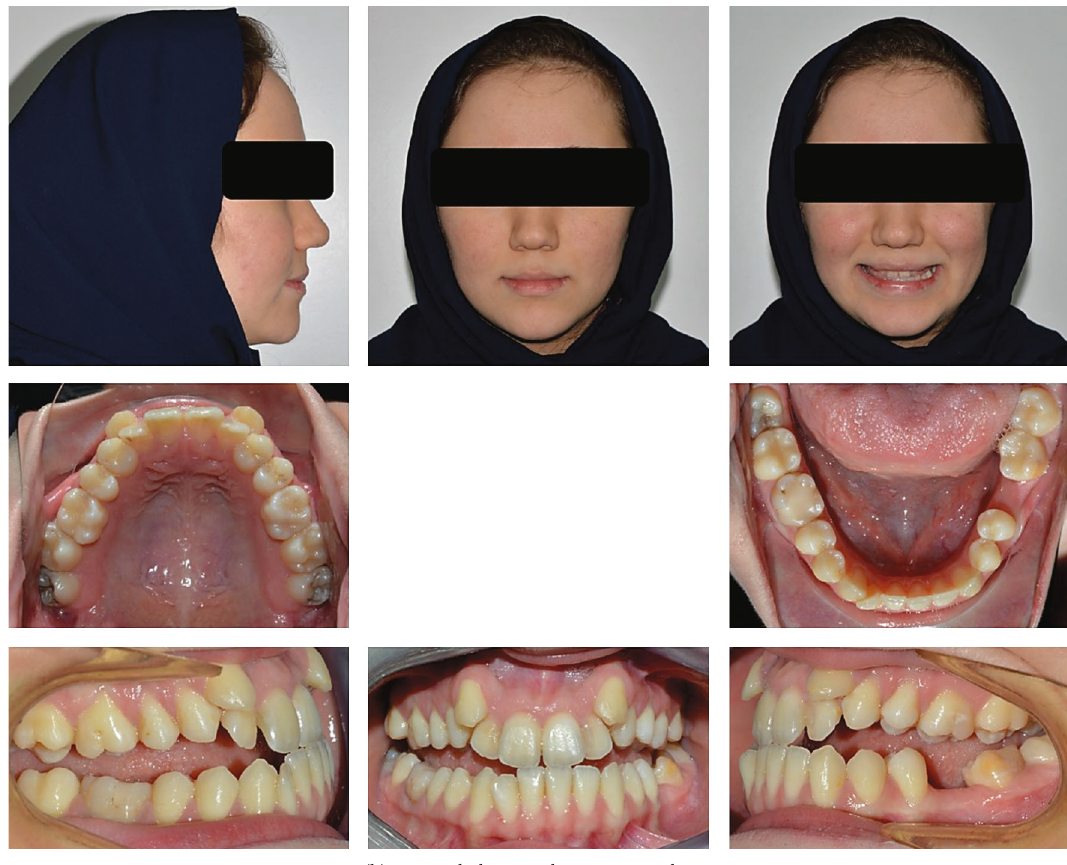
Figure 1: Pretreatment extraoral and intraoral photographs of the patient.